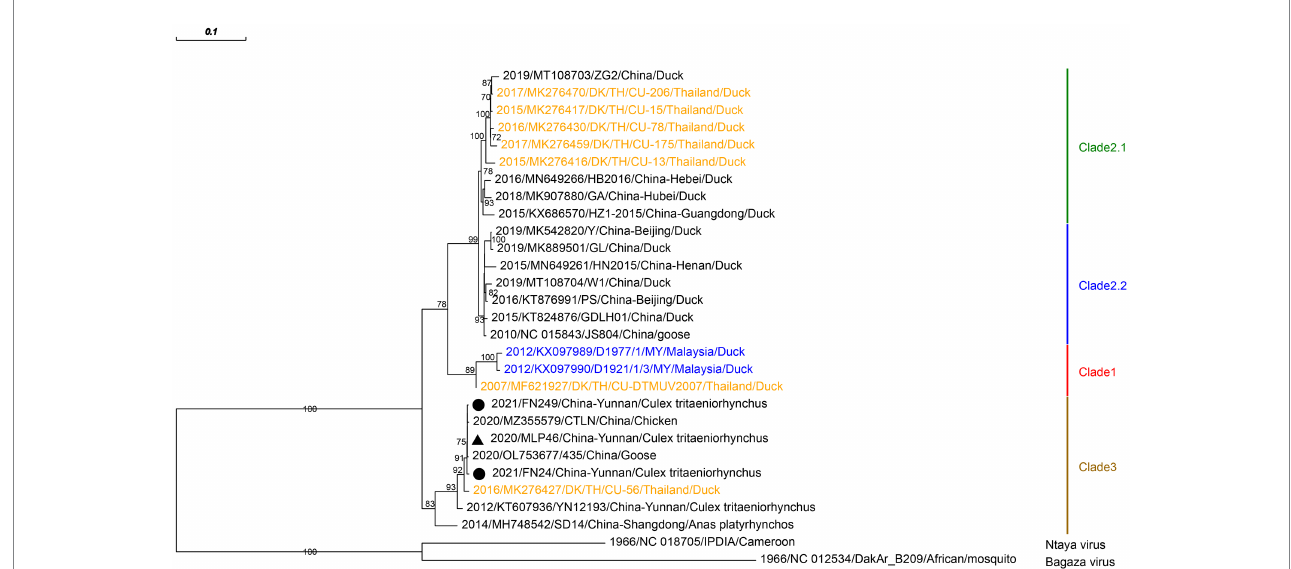
FIGURE 2 Phylogenetic analysis based on the nucleotide sequence of envelope protein sequences (1,503 bp) of TMUV. The phylogenetic tree was constructed by the maximum likelihood statistical method using IQtree v2.2.0 software. Bootstrap values were obtained from 1,000 replicates. Each TMUV sequence is denoted by year of isolation, GenBank accession number, strain, country of origin and isolation source. The sequences obtained from mosquitoes collected in Malipo county in this study are denoted by black triangle, and the sequences obtained from mosquitoes collected in Funing county in this study are denoted by black circle. Sequences from Malaysia and Thailand are indicated in blue and orange, respectively. Different clades are marked with different colors on the right. Branch scale bars are shown as 0.01 substitutions per site.